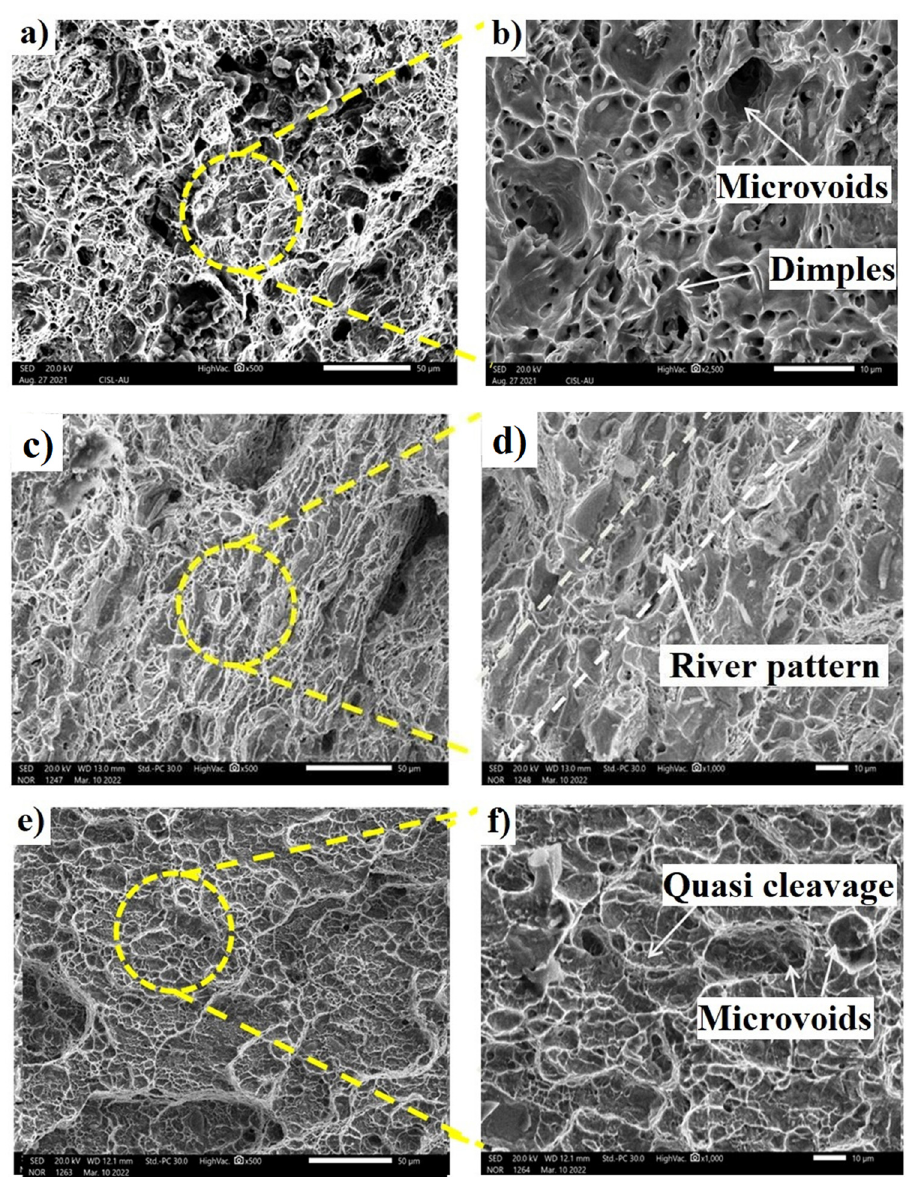
Figure 13: SEM fractograph of tensile specimens: ( a ) and ( b ) center region, ( c ) and ( d ) peripheral region, and ( e ) and ( f ) concourse